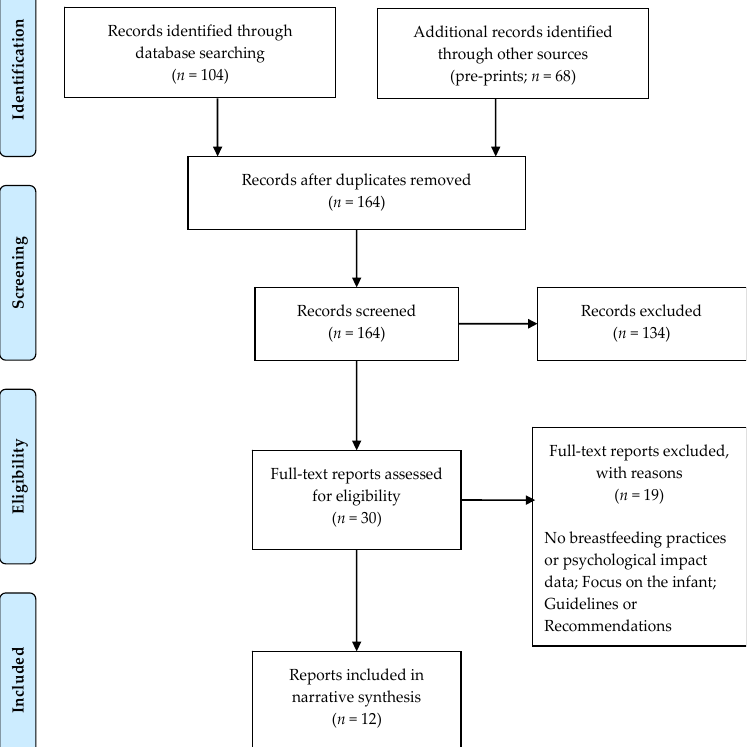
Figure 1. Flow diagram of the search and selection process.